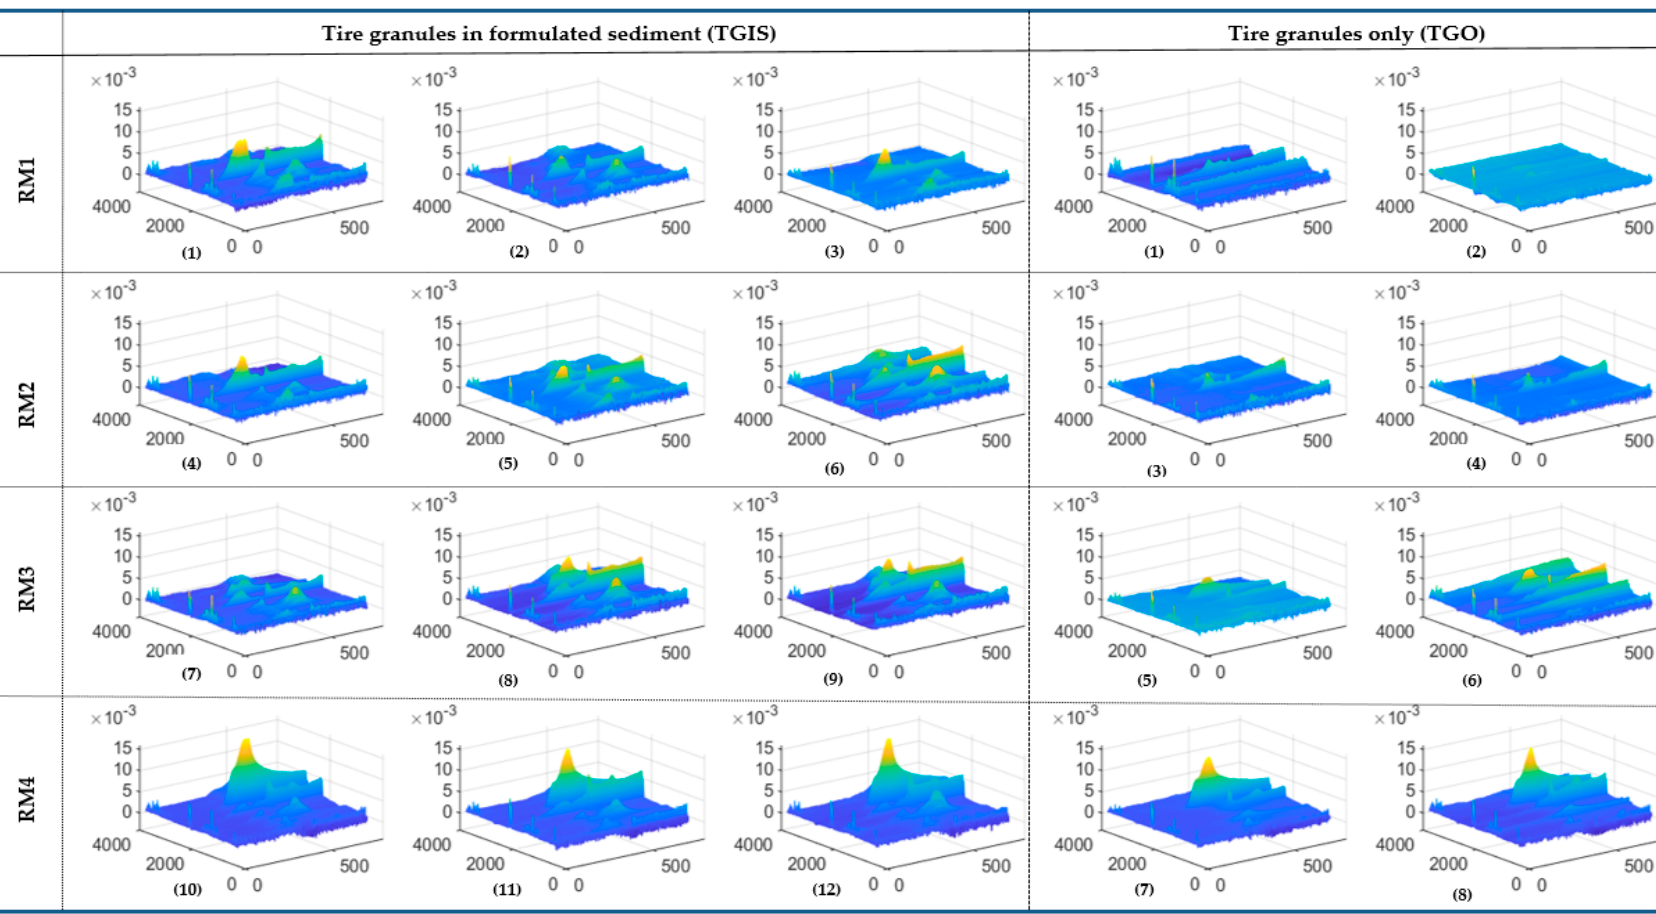
Figure 3. Landscape surfaces of the 20 raw FTIR spectral data. The first three columns in the figure are spectral data of samples in tire granules in formulated sediments (TGIS). The last two columns represent samples in tire granules only (TGO). The RM amount remain similar within rows and increase along the columns. The X-axis represent wavenumber (0 − 4000 cm − 1 ), Y-axis represent temperature (0 − 800 °C), and z-axis represent intensity of the spectra (absorbance).